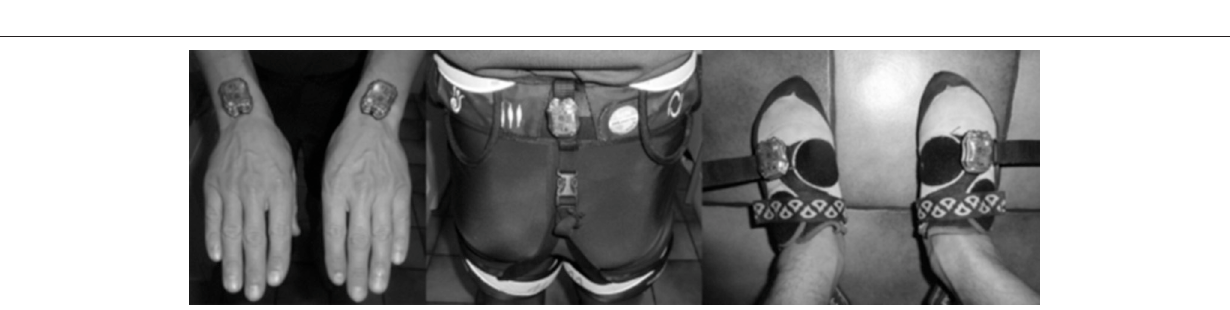
FIGURE 2 | Orientation and shape of the holds for the three routes. The arrow indicates the preferential grasping allowed by the hold. Adapted from Seifert et al. (2015).